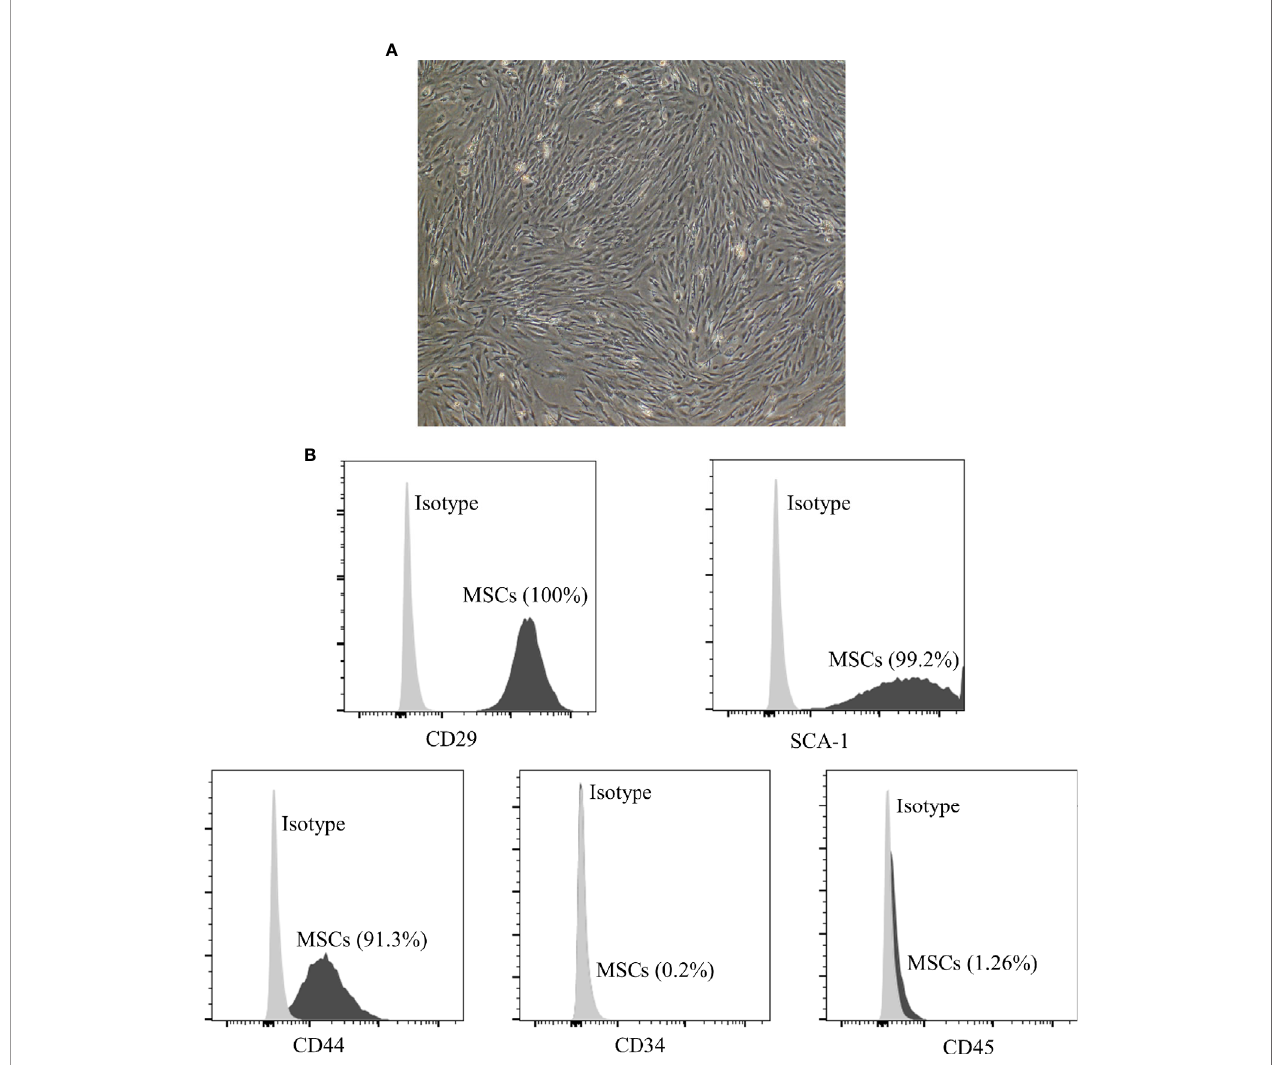
FIGURE 1 | Characterization of adipose derived MSCs. (A) Morphology of p3 passage MSCs. The section is displayed at 100× magni fi cation. The MSCs display a fi broblast-like or spindle-shaped morphology. (B) The expression of cell markers on the surface of MSCs measured by fl ow cytometry analysis. MSCs are positive for CD29 (100%), SCA-1 (99.2%), CD44 (91.3%), while negative for CD34 (0.2%) and CD45 (1.26%). MSCs, mesenchymal stromal